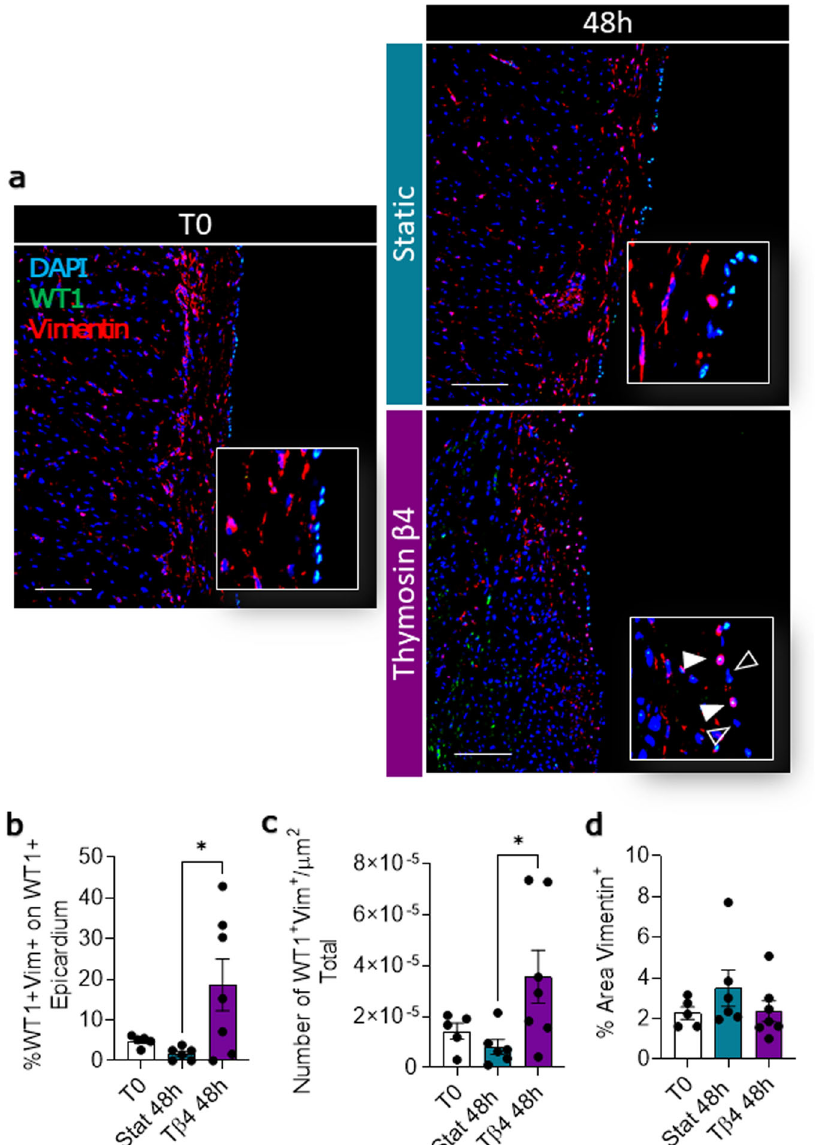
Fig. 12 T β 4 increases the differentiation into epicardial-derived mesenchymal cells. Representative images of WT1 + /Vimentin + cells in freshly cut slices (T0) and after 48 h of static (Stat) and thymosin β 4 (T β 4)-treated culture ( a ). Quanti fi cation of double-positive cells in the epicardial layer ( b ), and in the whole slice ( c ). Graph showing the quanti fi cation of vimentin area in the whole slice ( d ). White arrowheads indicating WT1 + /Vimentin + epicardial cells, empty arrowheads indicating WT1 − epicardial cells. N of pigs = 4 – 5, number of slices displayed in graphs. All graphs display data as mean ± SEM. * p ≤ 0.05. Scale bars, 100